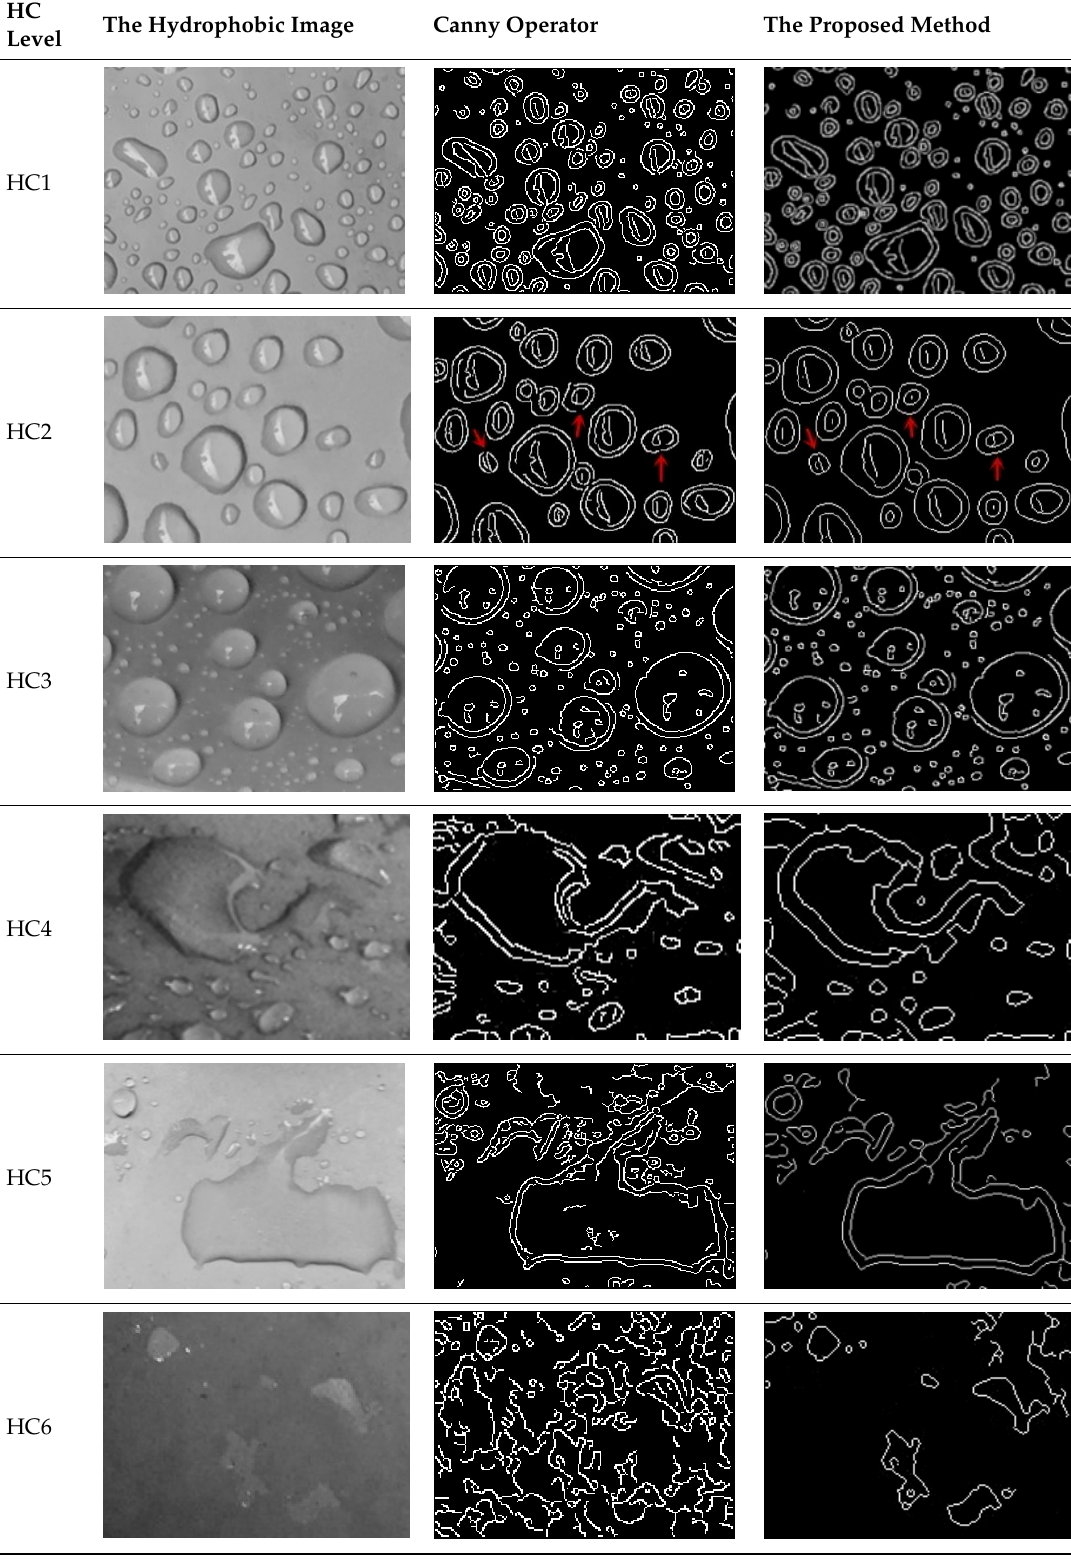
Table 2. Comparison of image segmentation algorithm.